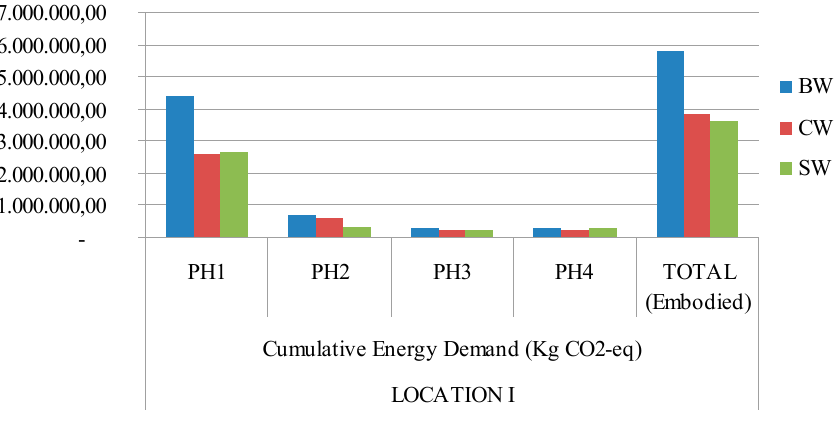
Figure 5. Cumulative energy demand (MJ) GWP 100a (Kg eq-CO 2 ) for each type of building construction